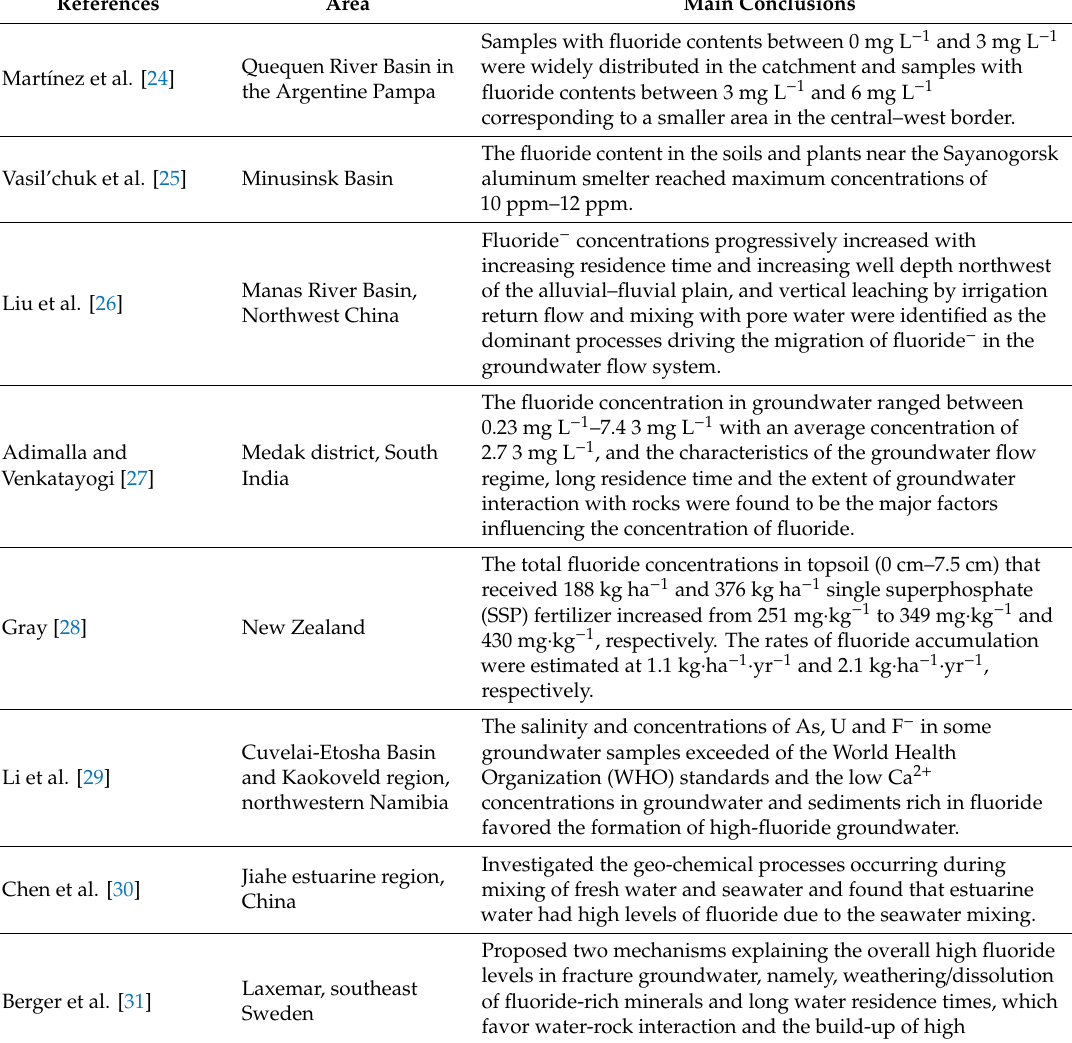
A summary of recent studies on the distribution, source and formation of high-fluoride